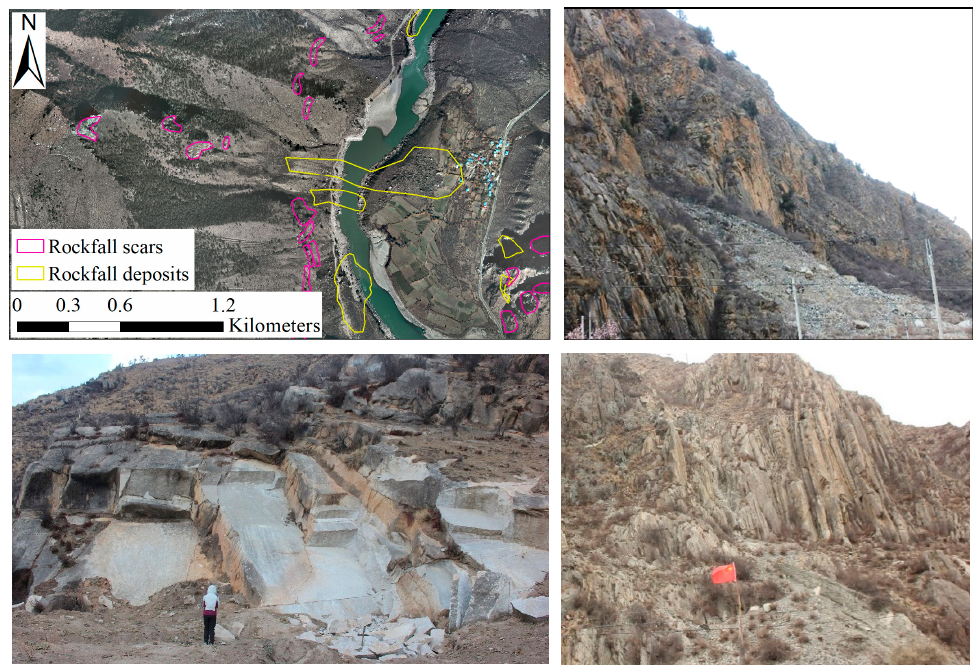
Figure 2. Samples of the rockfall scars and deposits on the helicopter-based remote sensing imagery with the location c in Figure 1b and the historical rockfalls with kinematic failure modes of toppling and planer sliding and their deposits at the foot of the slopes.